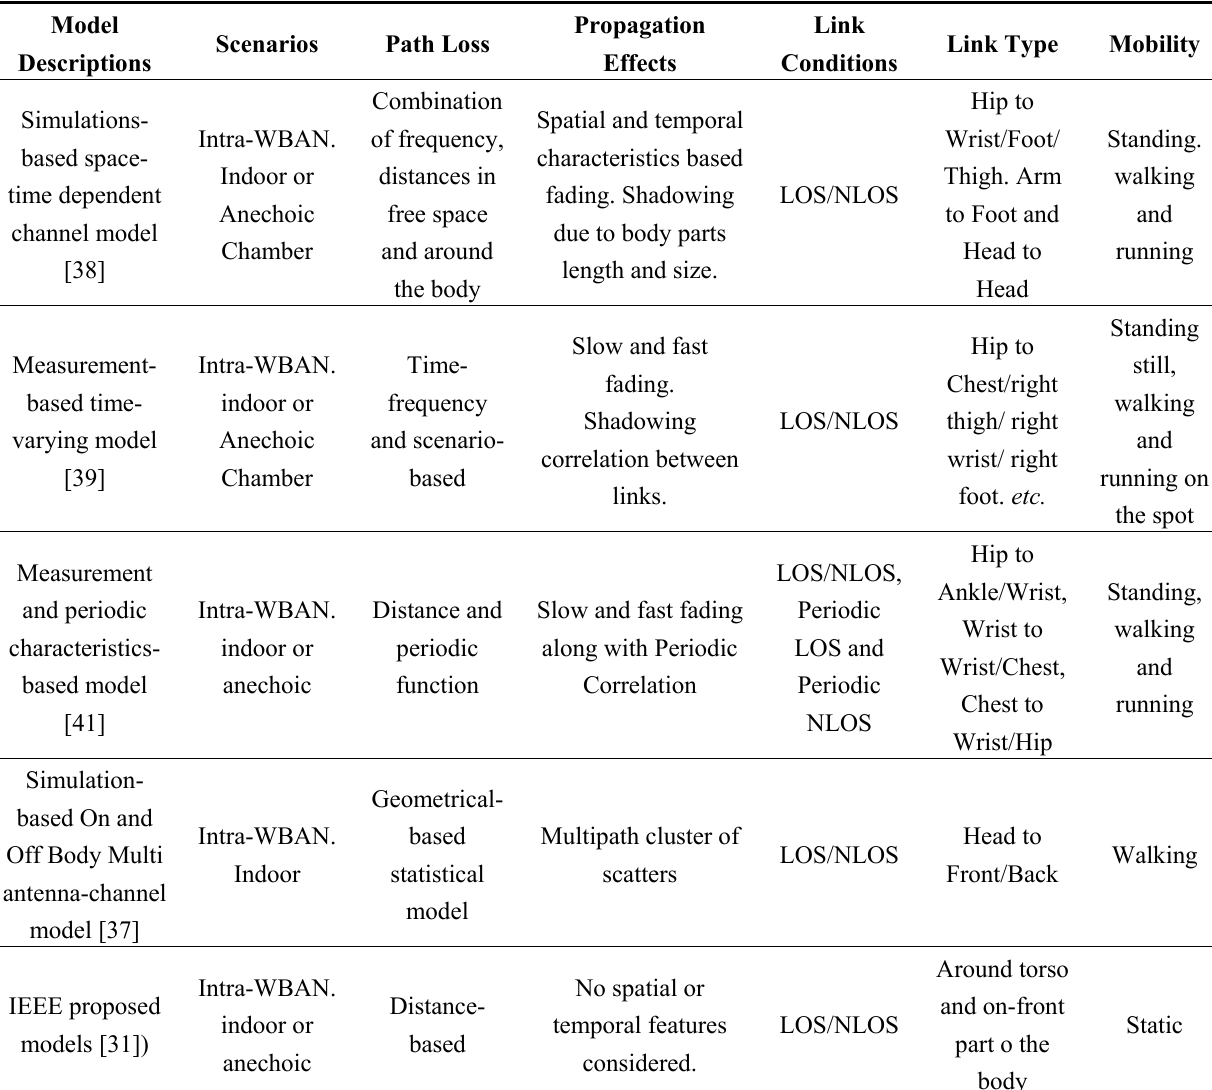
Table 7. Comparative analysis of existing channel